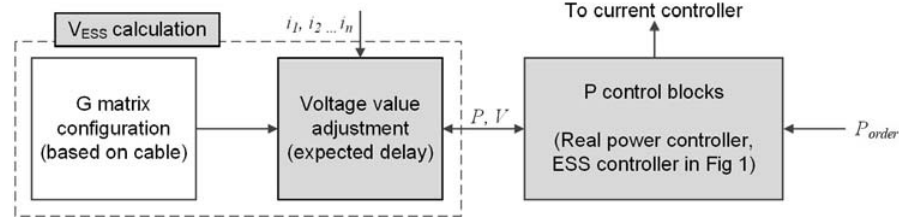
Figure 2. Description of added block for accuracy improvement method.